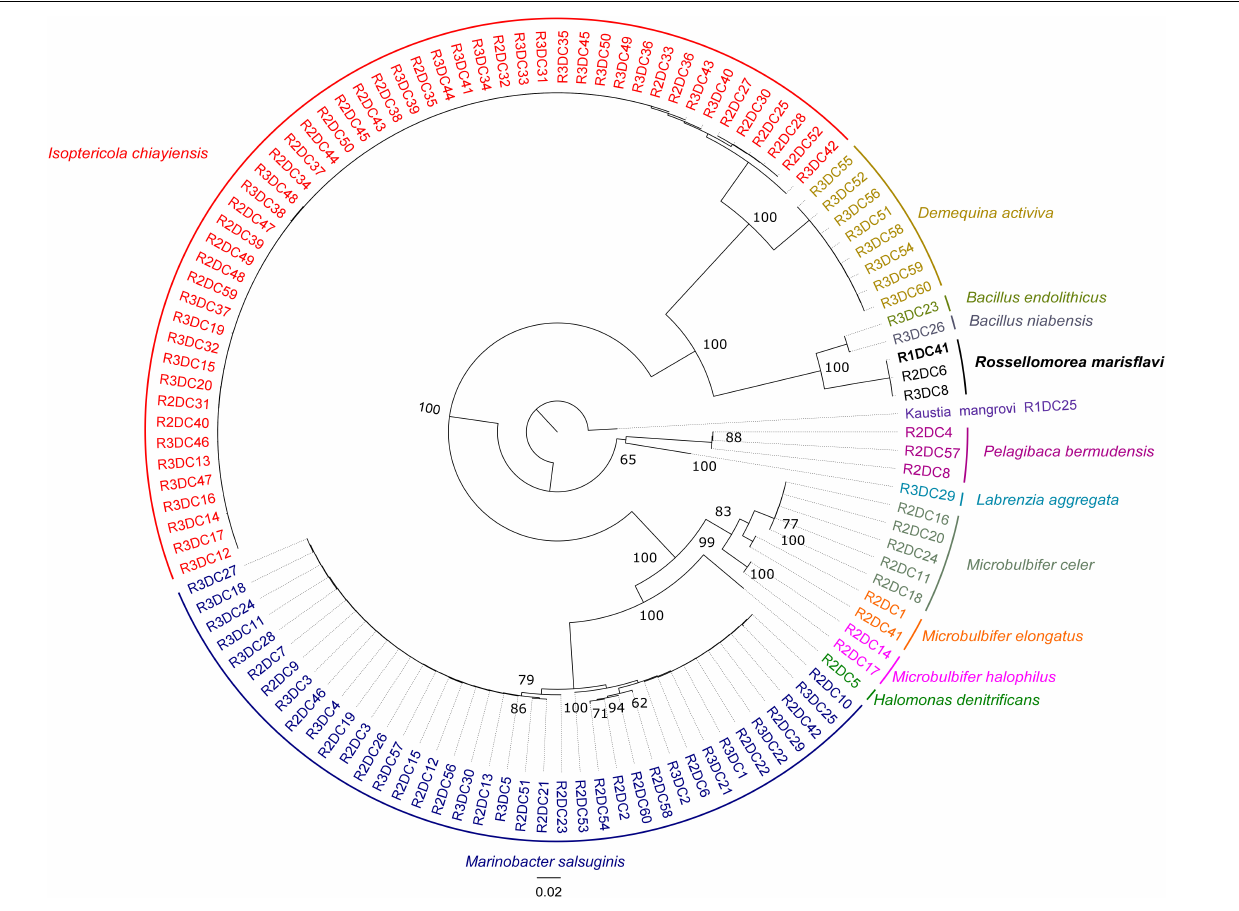
FIGURE 1 | Diversity of cultivable bacteria from mangrove sediments. Neighbor-joining phylogenetic tree based on the 16S rRNA gene sequences and reconstructed using the MEGA X software. Only bootstrap values (expressed as percentages of 1,000 replications) of > 50% are shown at branching points; the colors on the outer rings refer to the bacterial species and to the abundance of that bacteria in our collection (total, n = 115), respectively.